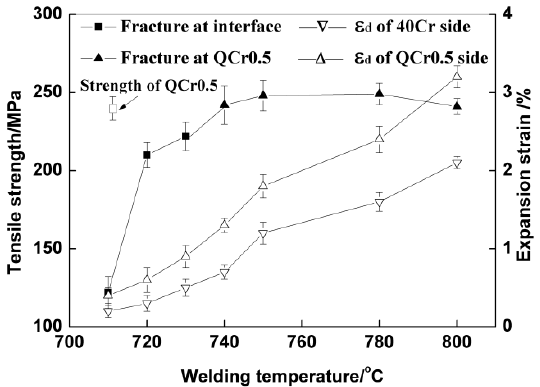
Figure 10. Curves of tensile strength and expansion strain vs. temperature. ( E = 3 kV/cm, t = 4 min, P 0 = 56.6 MPa, (cid:2013)(cid:4662) (cid:2868) = 1.5 × 10 − 4 s − 1 ).